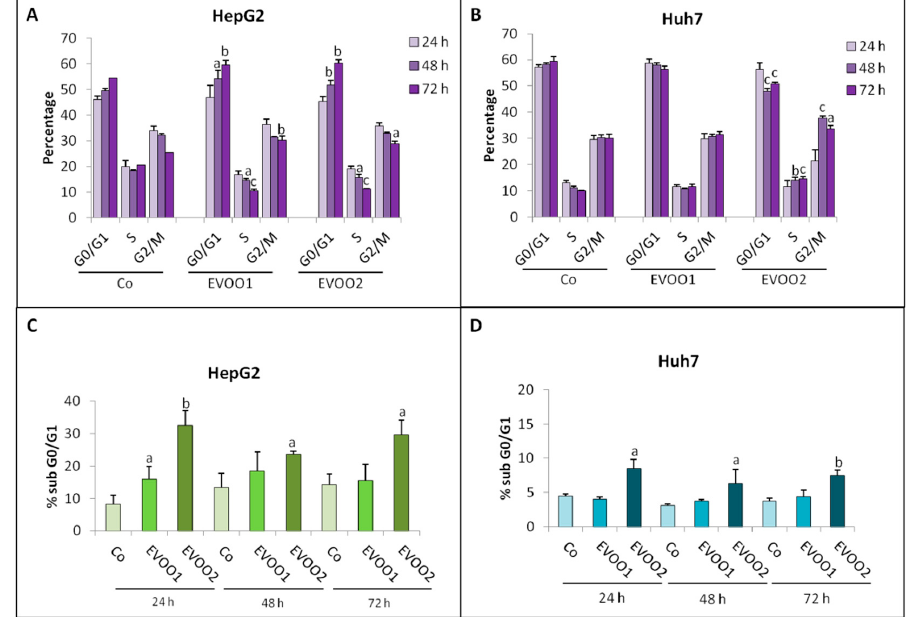
Figure 2. Phenolic extract alters cell cycle distribution of liver cancer cell. The cell lines were incubated for 24–72 h with two different doses of the EVOO extract. ( A , C ) Distribution in the cell cycle and percentage of cells in sub G0/G1 of HepG2 cell line. ( B , D ) Distribution in the cell cycle and percentage of cells in sub G0/G1 of Huh7 cell line. The results are representative of three experiments. Data are presented as mean ± SD. (a: p < 0.05, b: p < 0.01, c: p < 0.001 versus Control).